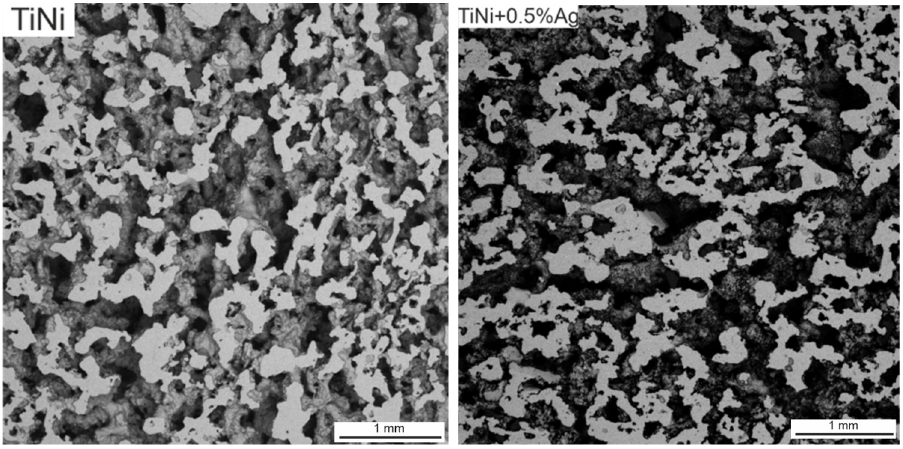
Figure 3. The cross-sectional SEM image of SHS–TiNi porous alloys specimens.